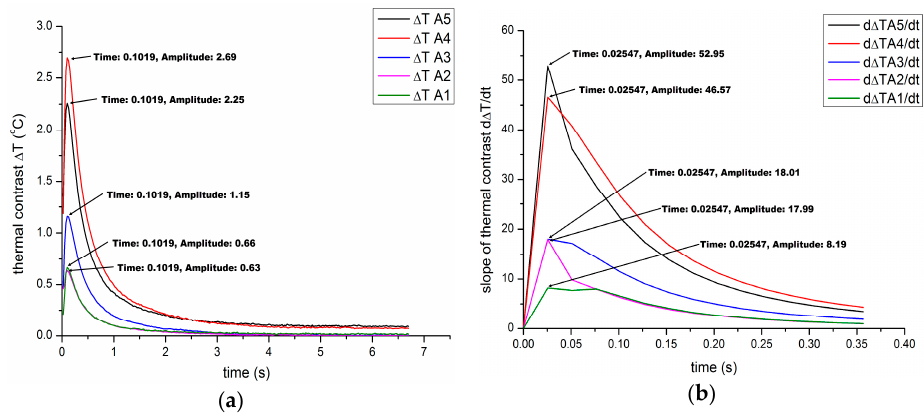
Figure 4. Temporal evolution of: ( a ) the thermal contrast curves; and ( b ) the correspondent slope of the thermal contrasts for the detected insertions on the trapezoid surface located to the depth of 0.2 mm (Series A).